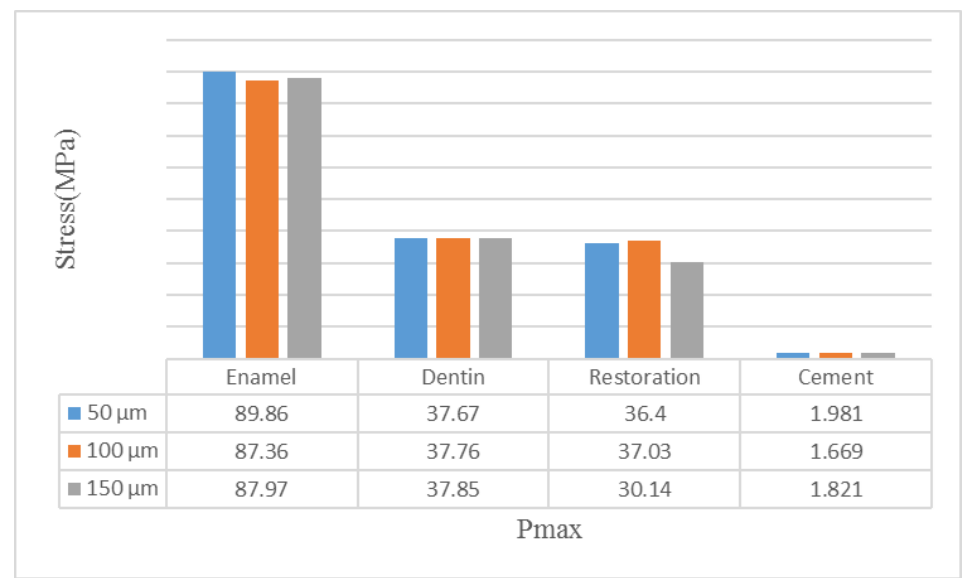
Figure 10. Maximum principal stress distribution in restorations applied with GI of different thick- nesses (50 GPa Young’s modulus of amalgam).